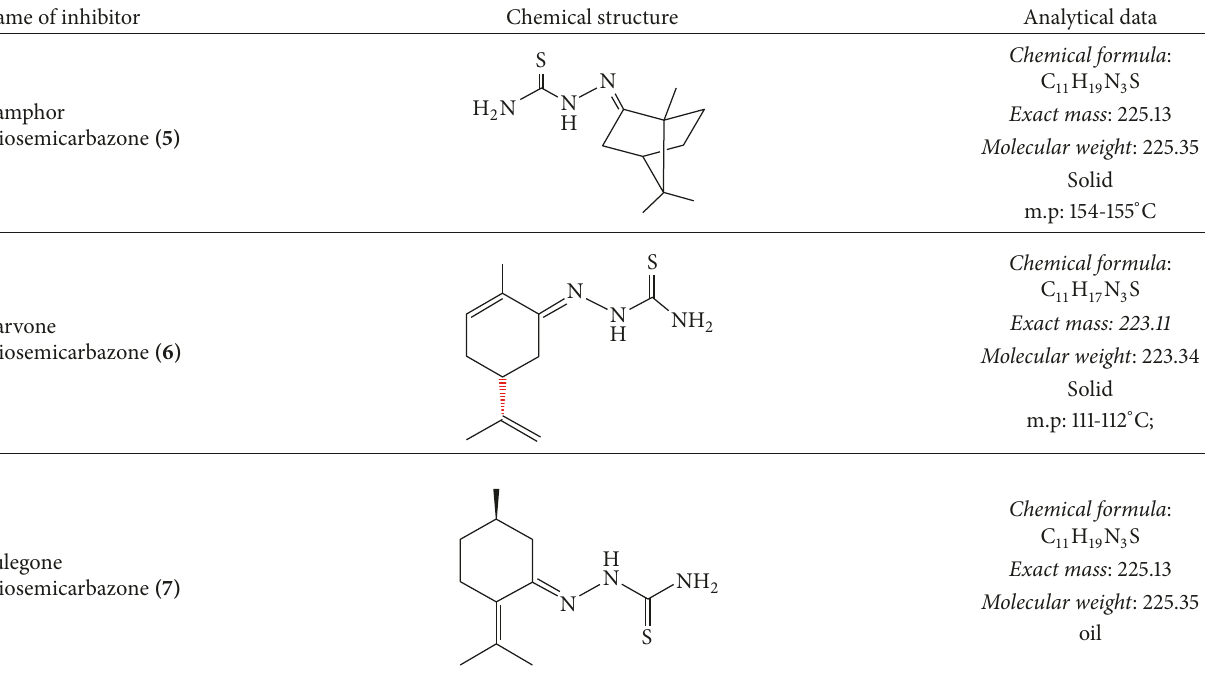
Table 1: IUPAC name, molecular structure, molecular formula, melting point, and analytical data of studied Monoterpenic Thiosemicar- bazones.